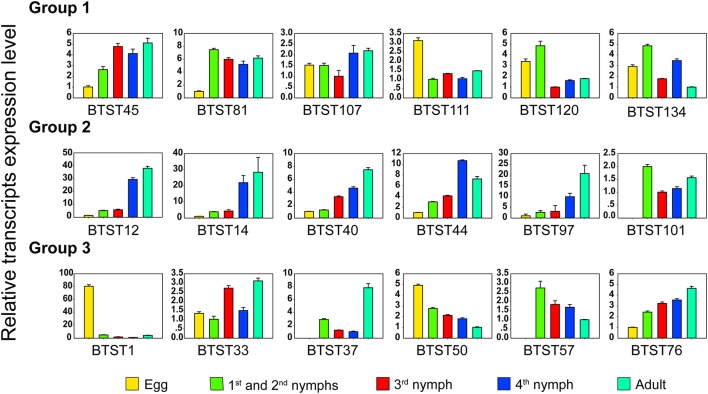
Expression profiling of BTSTs across different developmental stages based on RT-qPCR. E, eggs; N1-2, 1st and 2nd instar nymphs; N3, 3rd instar nymphs; N4, 4th instar nymphs; A, female and male adults.